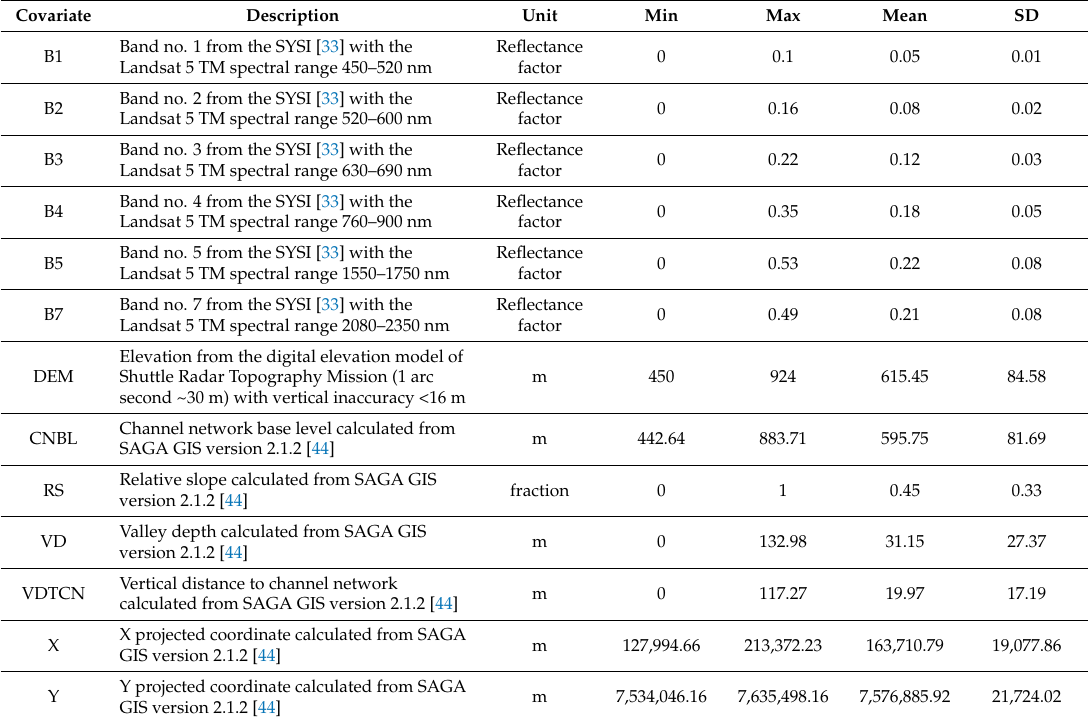
Figure 2. The Synthetic Soil Image (SYSI) ( a ) and Digital Elevation Model (DEM) ( b ) of the study area. Table 2. Descriptive statistics of the environmental covariates used for clay and sand mapping. Covariate Description Unit